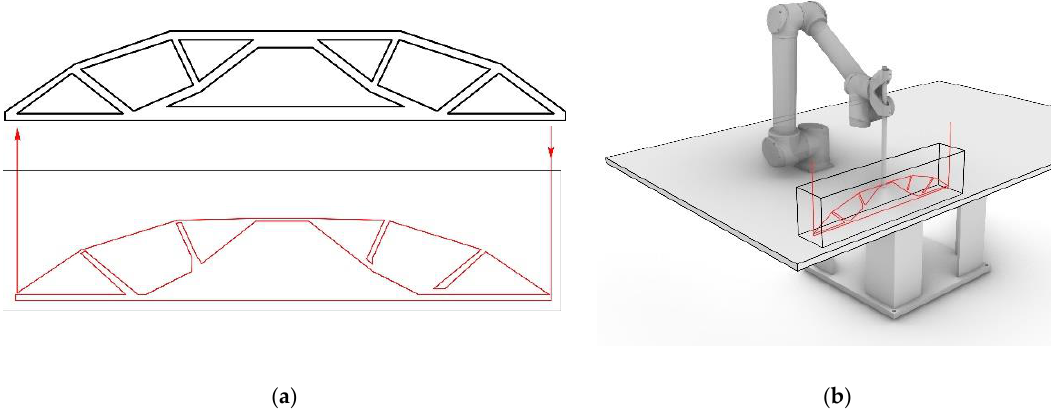
Figure 14. Object for process verification, (CiC): ( a ) topology optimized beam (top), robotic fabrication path (bottom); ( b ) simulation of the fabrication process.